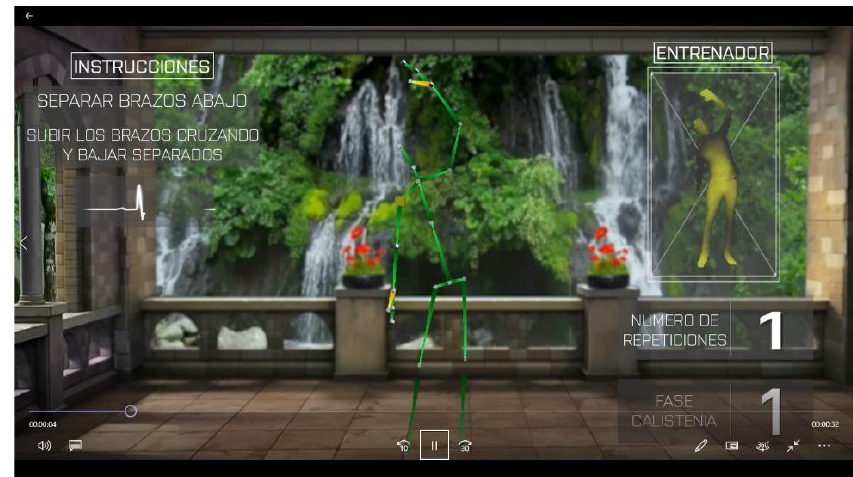
Figure 3. Implemented application related to diabetes.